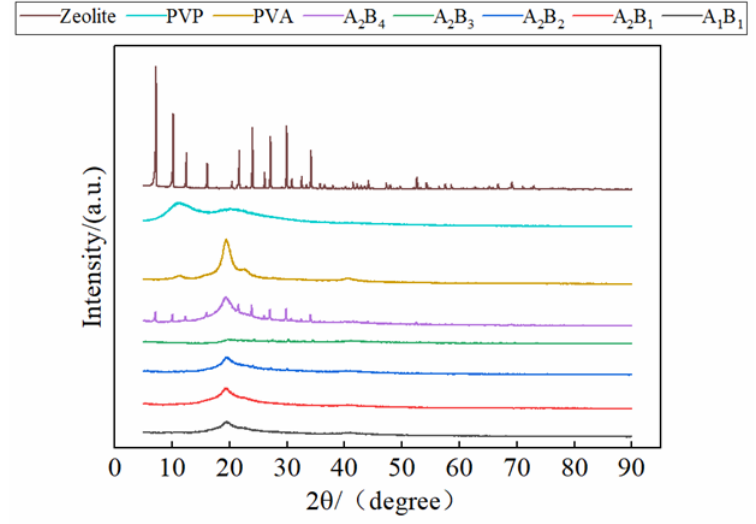
Figure 6. XRD of membrane materials under different